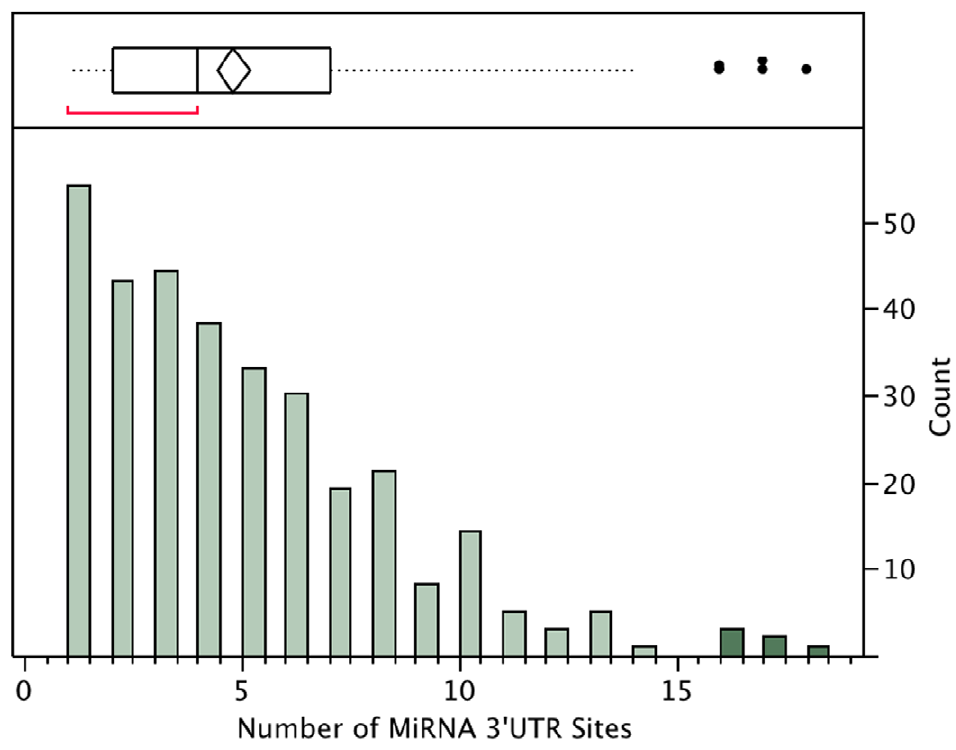
Figure 8. Number of dysregulated miRNA 3 9 UTR sites in dysregulated mRNAs. The number of miRNA targets sites for each dysregulated gene is counted and distribution shown (bottom) with outlier plot (top), six genes were outliers with 16–18 targets sites while the median was four target sites for each mRNA.